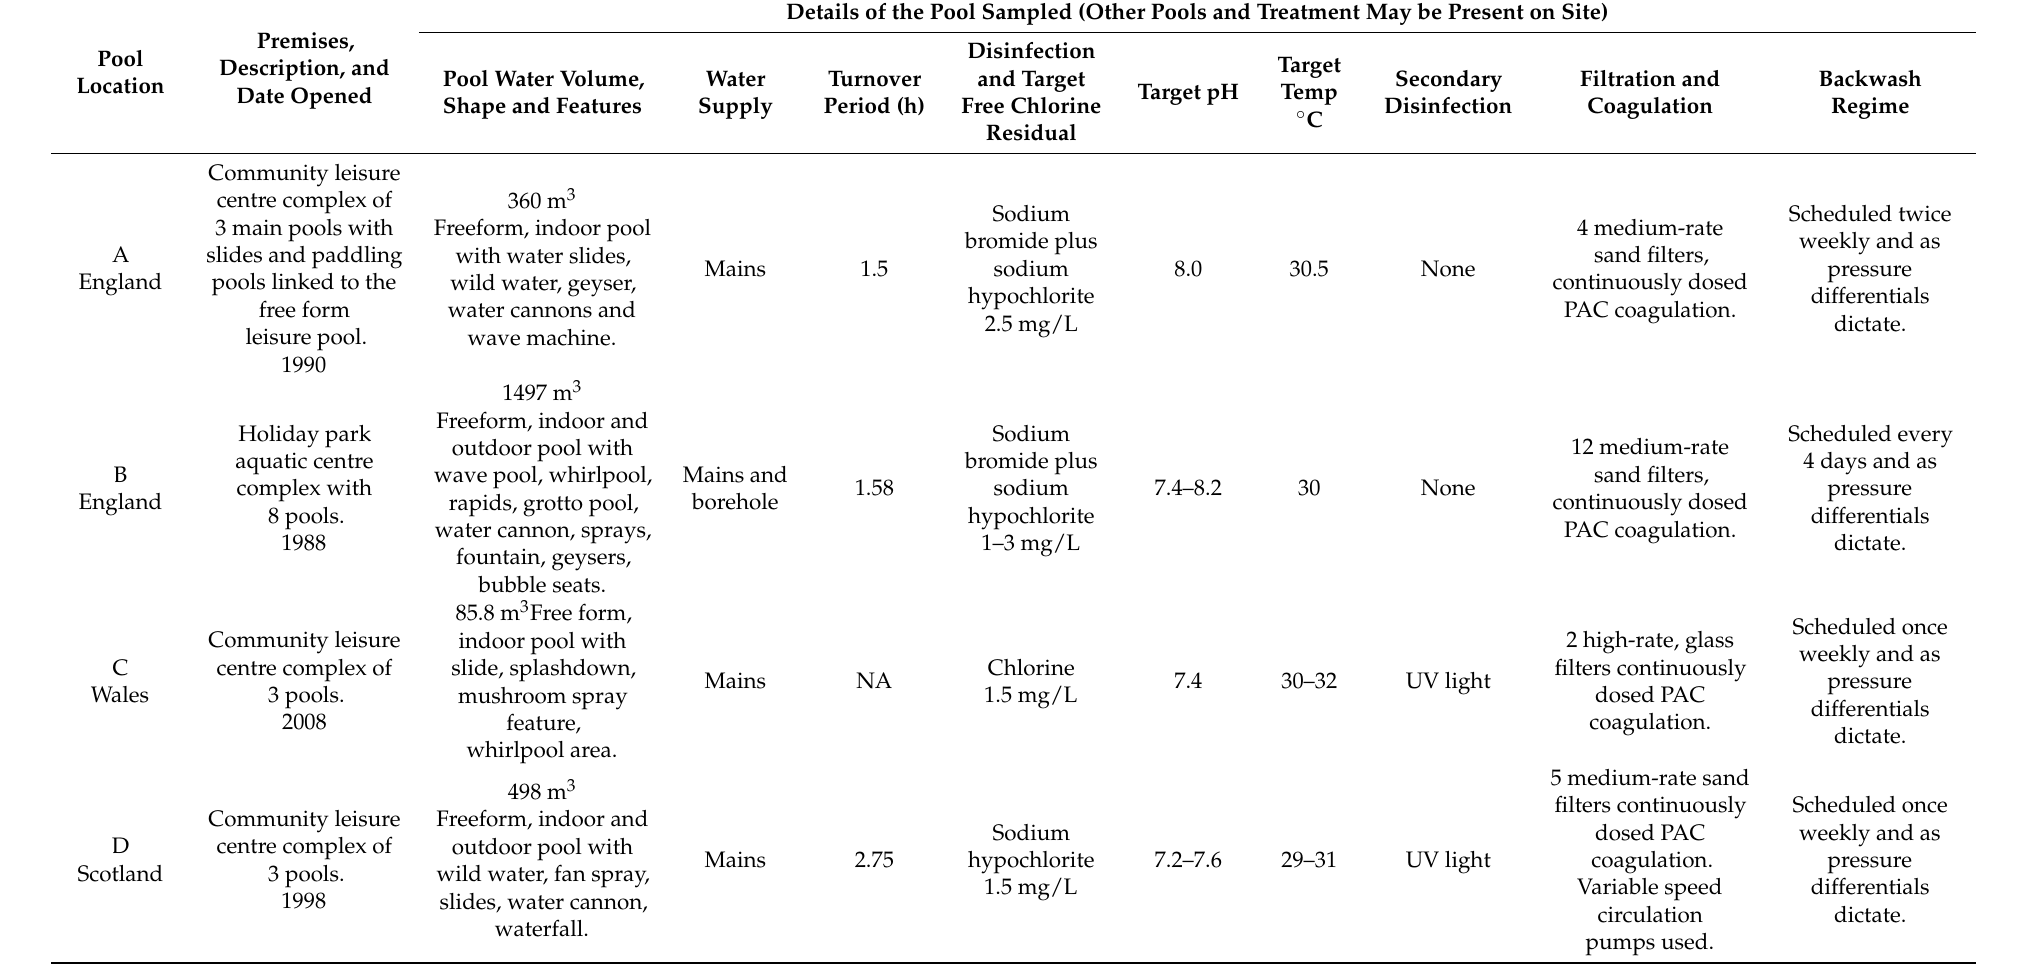
Table 2. Characteristics of the leisure pools